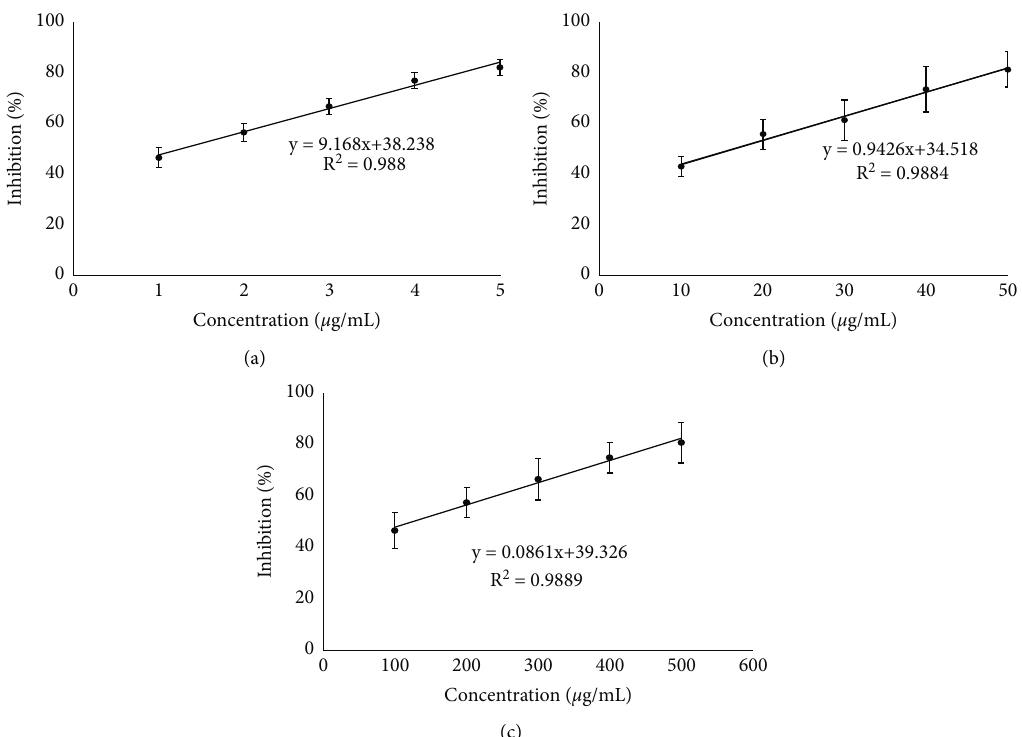
Figure 4: The antioxidant activity of (a) ascorbic acid, with IC 50 value of 1.28 ± 0.23 μ g/mL; (b) R . tuberosa (L.) extract, with IC 50 value of 16.42 ± 2.12 μ g/mL; and (c) microcapsules of R . tuberosa (L.) extract prepared in pH 4, 0.1% (w/v) chitosan concentration and 90min stirring time, with IC 50 value of 123.97 ± 9.33 μ